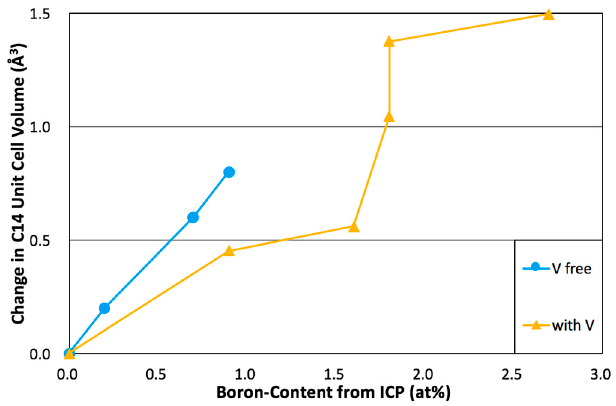
Figure 3. C14 unit cell volume change vs. boron content in the V-free [15] and V-containing AB 2 alloys.